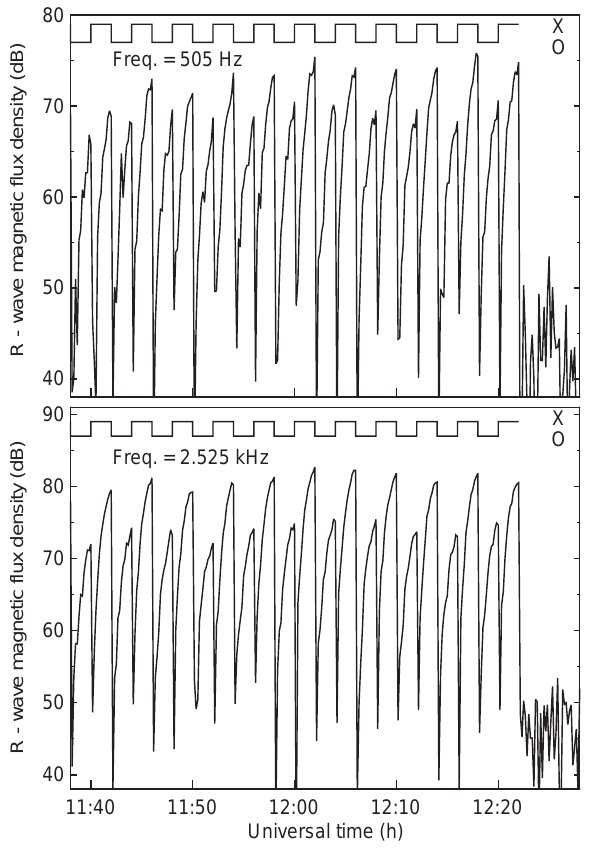
Fig. 8. ‘R’ wave magnetic flux density as measured at the Oststation. Upper panel : Measurements at the fundamental frequency of 505 Hz. Lower panel : Measurements at the harmonic frequency of 2525 Hz. The crenellated waveform at the top of each panel shows when the heater transmitter was switched between ‘X’ and ‘O’ mode transmis-